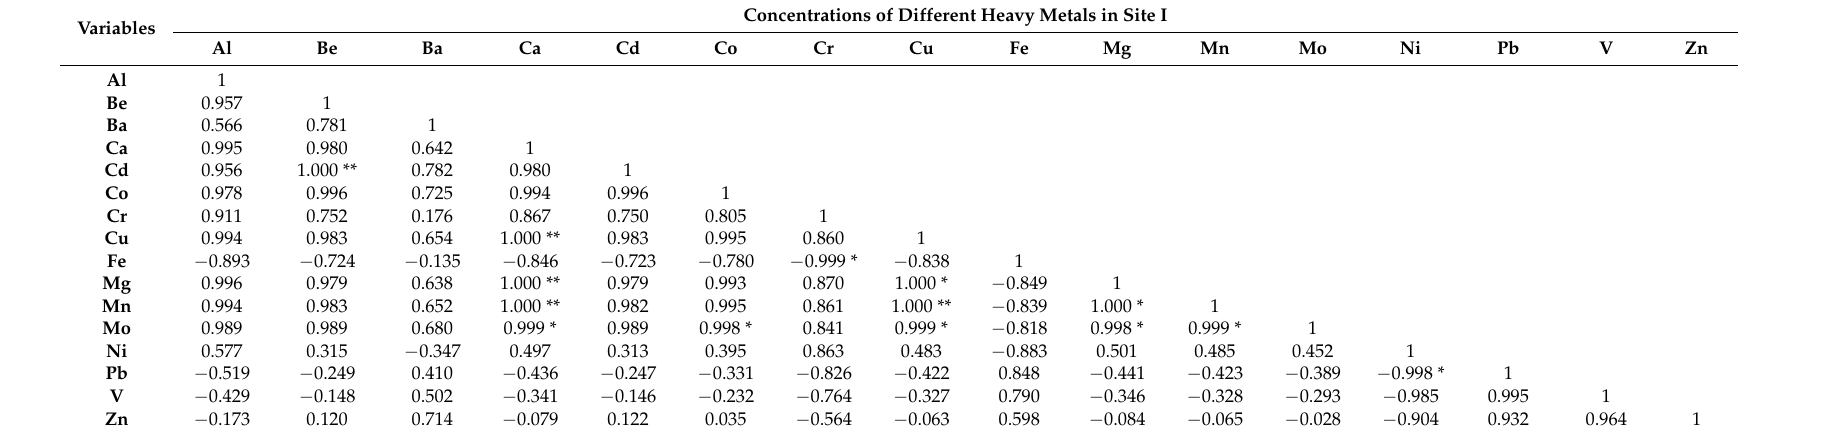
Table 8. Correlation between the concentrations of heavy metals in A. ochraceus of Site II (Taif).